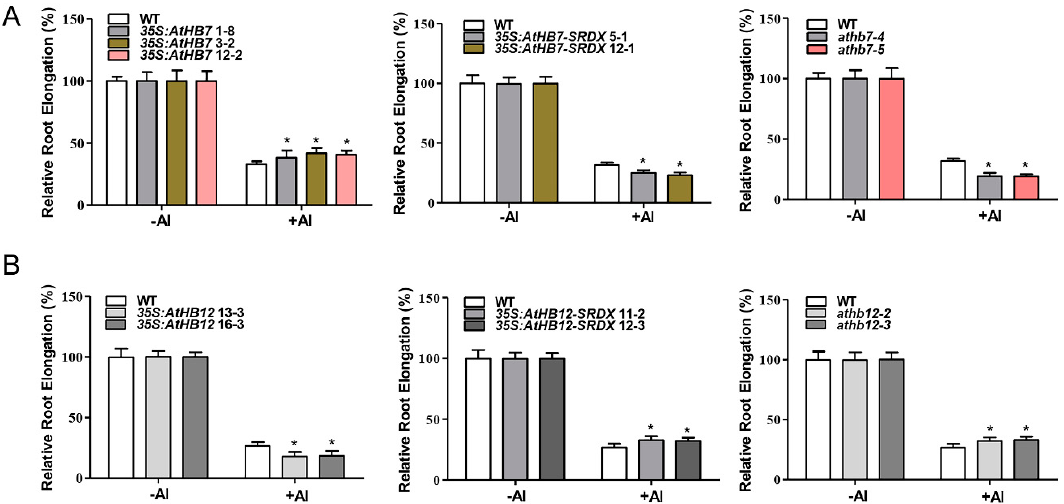
Figure 5. AtHB7 positively regulates Al resistance ( A ), whereas AtHB12 negatively regulates Al resistance ( B ). Relative root elongation of wild type, AtHB7 ( A ) and AtHB12 ( B ) overexpression, SRDX and CRISPR lines in response to 6 µ M Al for 6 days. Data are means ± SD ( n = 30). Asterisks indicate significant differences between wild type and transgenic seedlings at *: p < 0.05 by Tukey’s test.